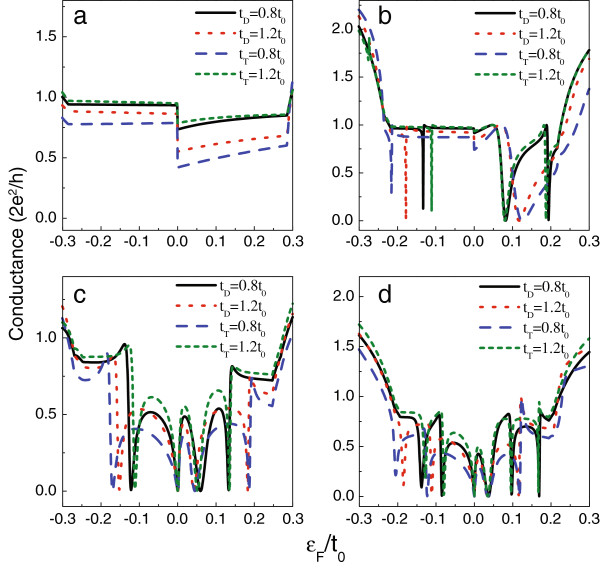
The effect of the change oftd andtT on the AGNR conductance. In (a to d), M is taken to be 17, 23, 20, and 26, respectively.